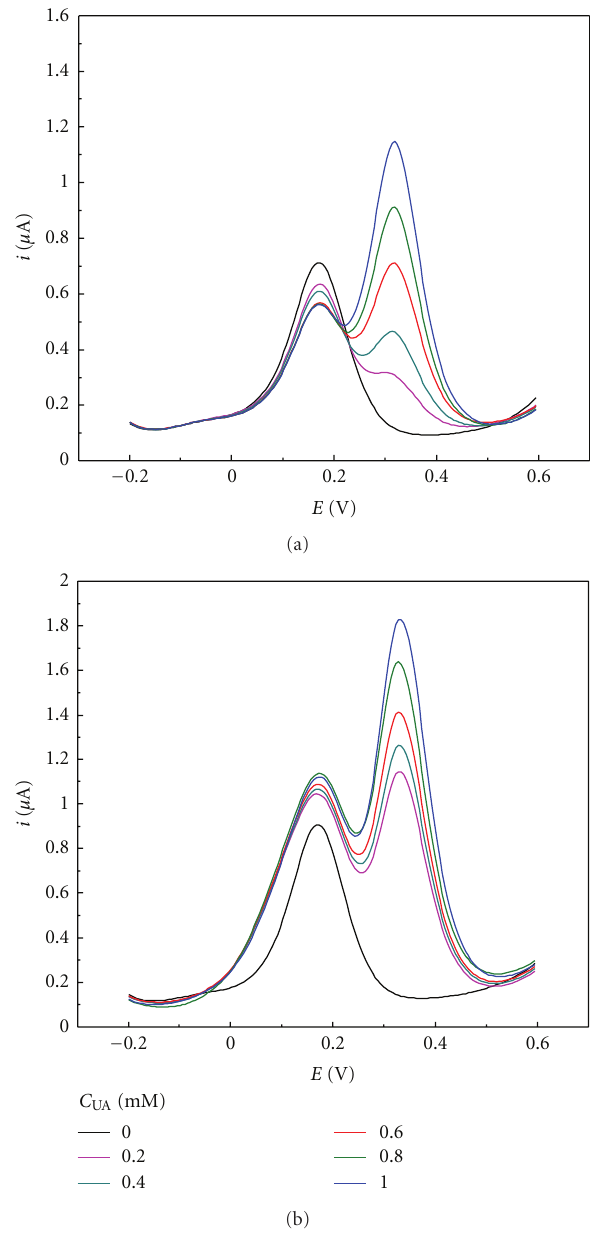
Figure 7: Di ff erential pulse voltammograms of UA at the concen- tration increasing from 0 to 1.0 mM (0.2 mM step) in the absence (a) and presence of 1 mM AA